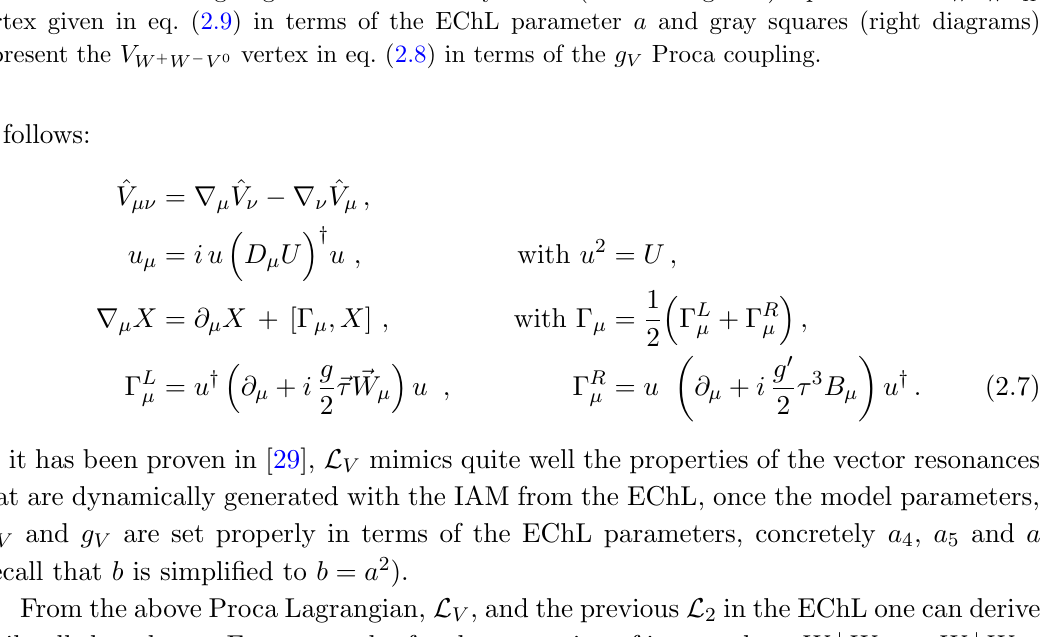
! W + W in the Unitary gauge (cid:0) (cid:0) W + W (cid:0) H